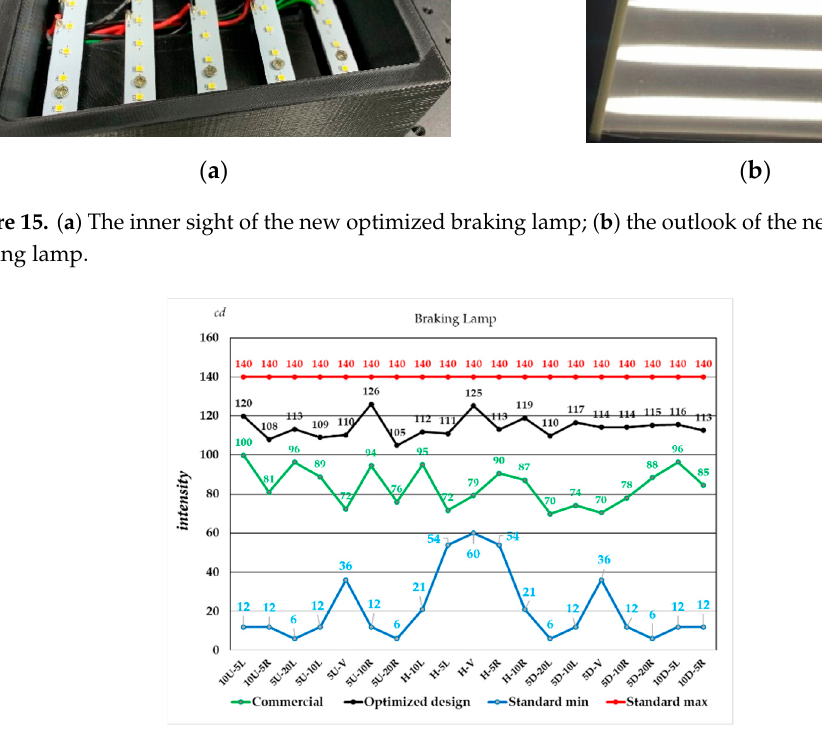
Figure 16. The comparison of the measured optical intensity with respect to each considered angle of EU ECE regulation between the new optimized braking lamp prototype and the commercial sample.